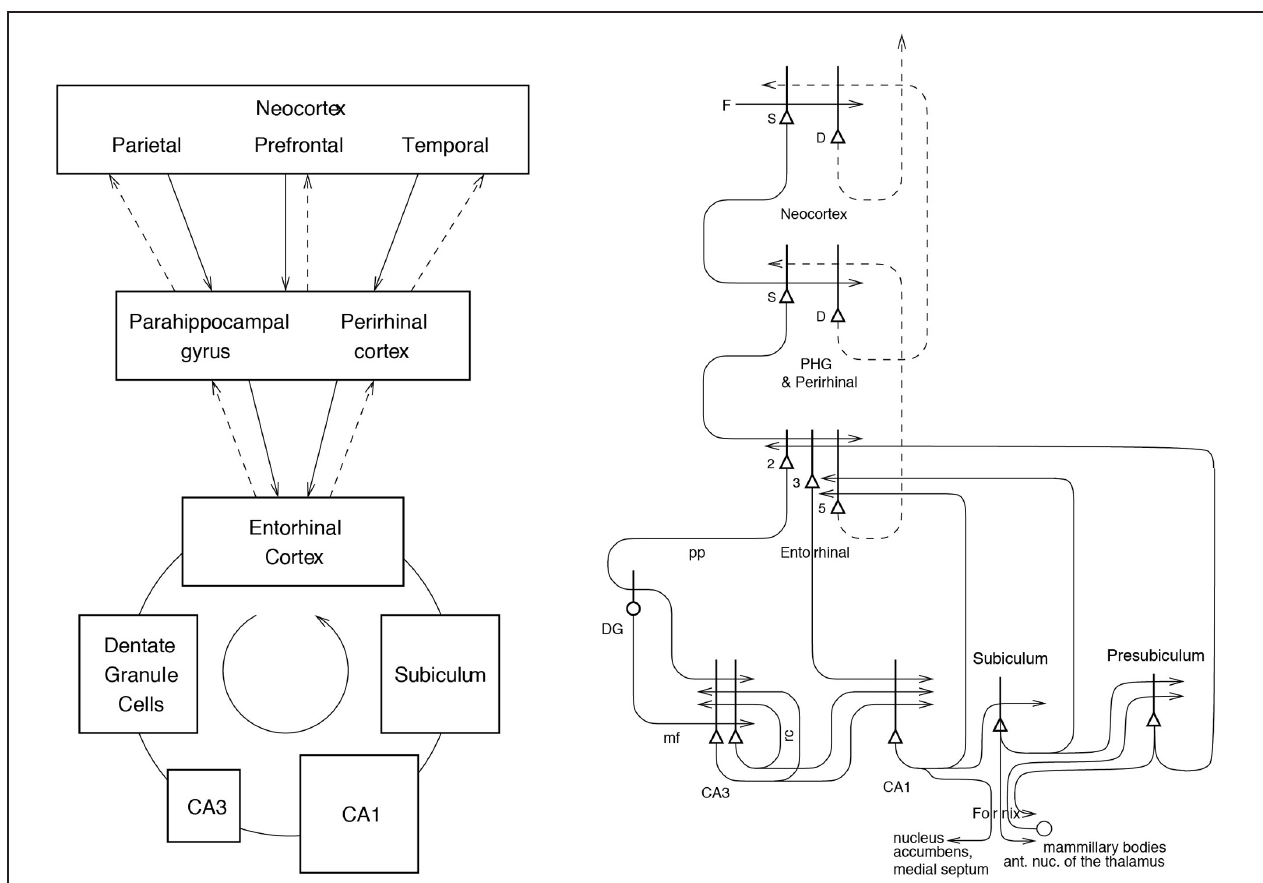
excitatory neurons in the pathways. Abbreviations: D, Deep pyramidal cells; DG, Dentate Granule cells; F, Forward inputs to areas of the association cortex from preceding cortical areas in the hierarchy; mf, mossy fibers; PHG, parahippocampal gyrus and perirhinal cortex; pp, perforant path; rc,